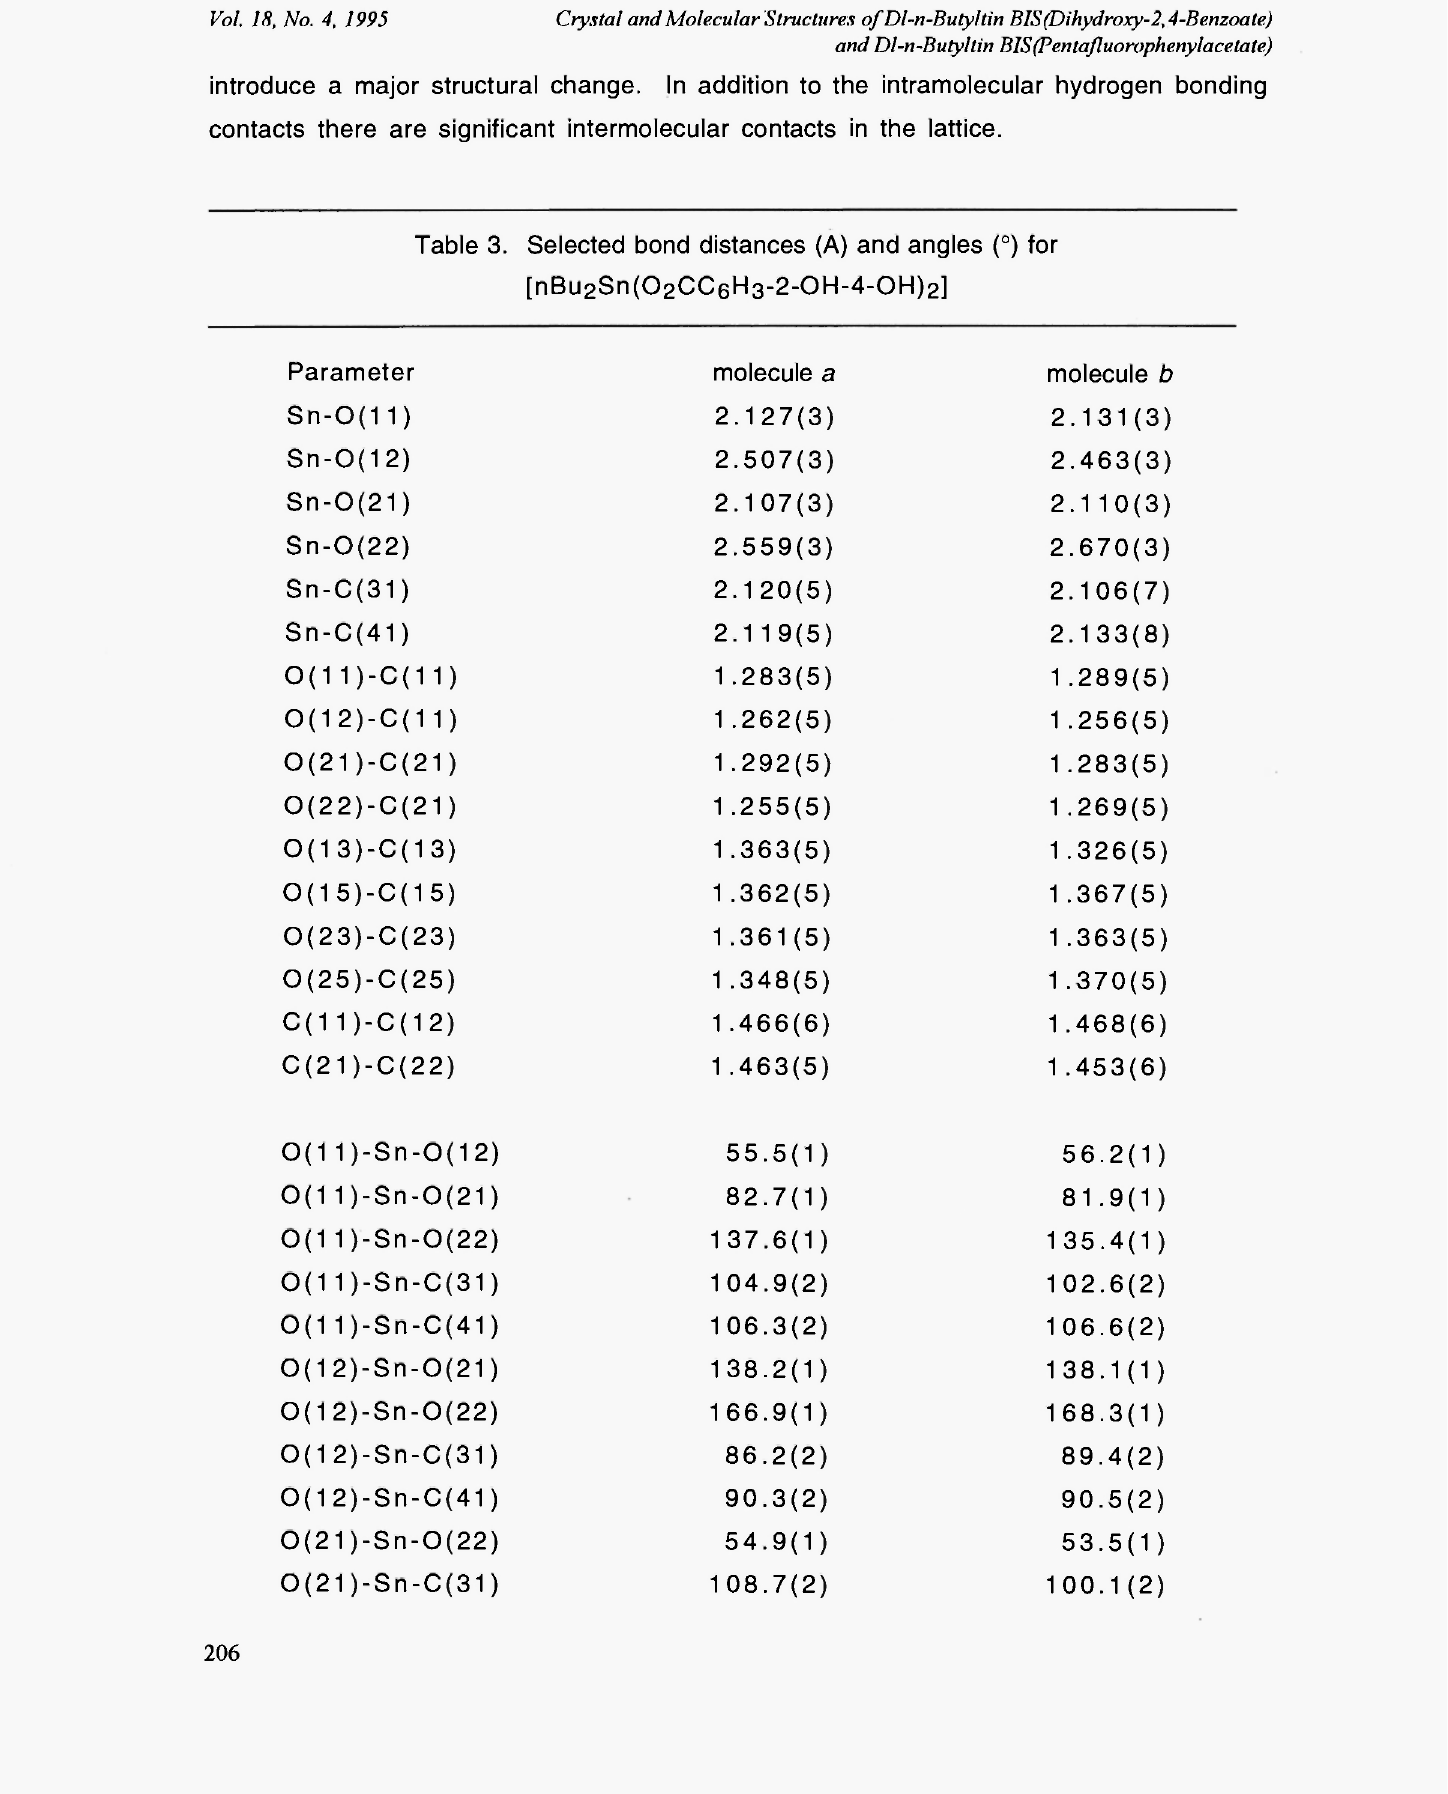
Table 3. Selected bond distances (A) and angles (°)